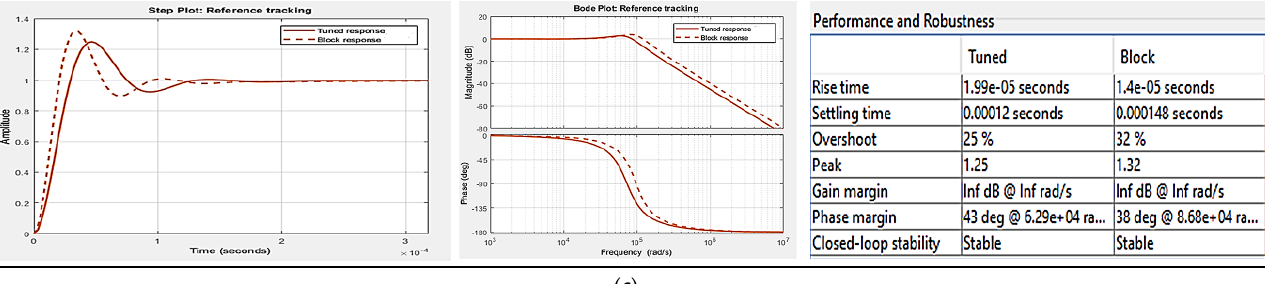
Figure 13. ( a ) PSIM simulation results of P o and P max . ( b ) PSIM simulation results of V cell and V L . ( c ) MATLAB-based results of controller.